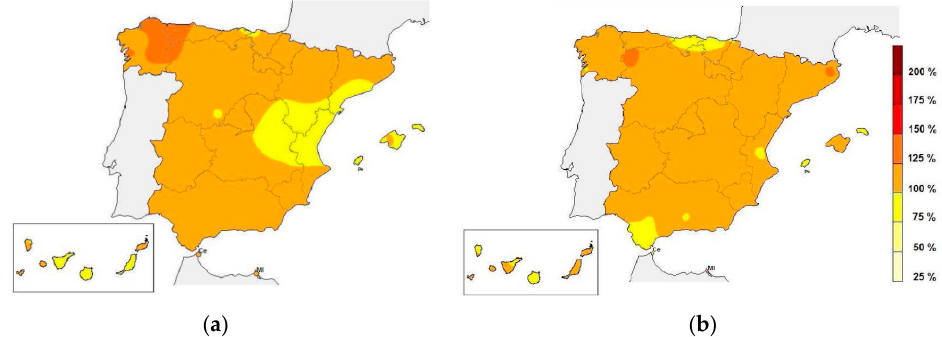
Figure 15. On the ( a ) is shown the August 2013 radiation on Spain [43], on the ( b ) is the September 2013 radiation